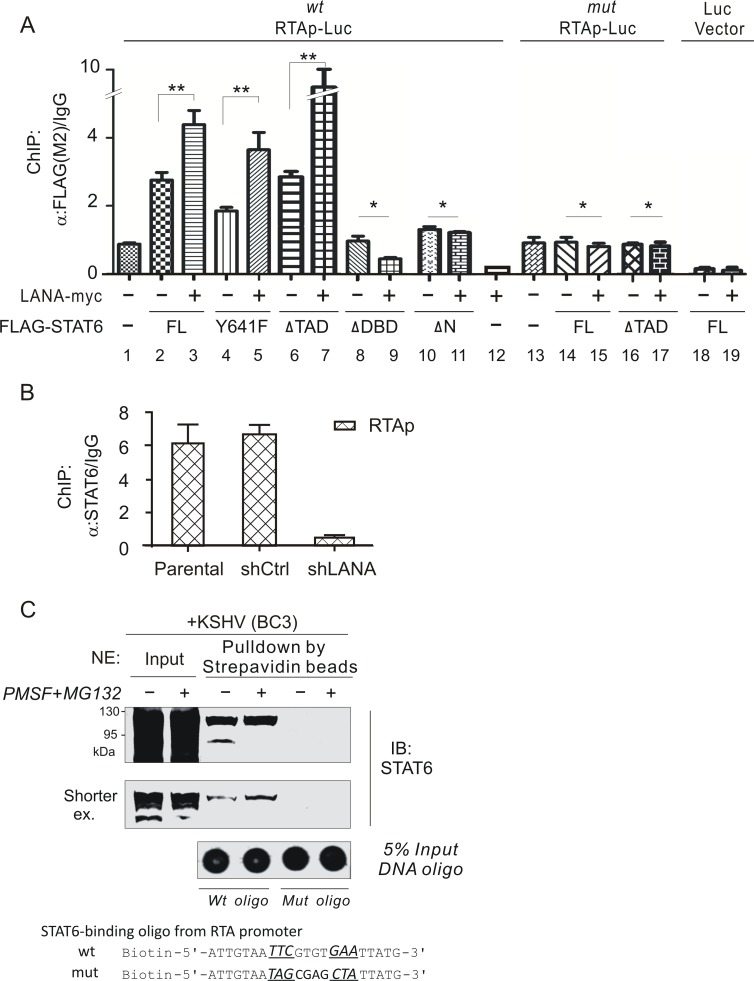
LANA enhances the affinity of STAT6 bound to RTA promoter.(A) Intact or cleaved form of STAT6 bound to RTA promoter and enhanced by LANA. HEK293 cells co-transfected with the indicated plasmids, were subjected to Chromatin immunoprecipitation (ChIP) with exogenous STAT6 (full length, Y641F, ΔTAD, ΔDBD, and ΔN). Non-specific mouse IgG and the pGL-3 reporter vector were individually used as control. The relative levels of STAT6 bound to RTA promoter were detected by quantitative PCR. Data is presented as means±SD of three independent experiments. Asterisks indicate P value as follows: *, P>0.05, and **, P<0.05. (B) Knockdown of LANA reduces the affinity of STAT6 with RTA promoter. Parental and BC3 cells with lentivirus-mediated constitutively knocked down of LANA (shLANA) or luciferase control (shCtrl) from panel A in Fig 3, were subjected to ChIP assay with endogenous STAT6 as described in panel A. (C) In vitro DNA-binding assays of intact STAT6 and its cleaved form from PEL cells. Nuclear extracts (NE) from KSHV-positive BC3 cells with or without PMSF and MG132 treatment, were individually incubated with wild-type or mutant STAT6-binding DNA oligonucleotide derived from RTA promoter followed by three washings, and the precipitates were immunoblotted with STAT6 antibody. Five percent input of DNA oligonucleotide is shown at the bottom.